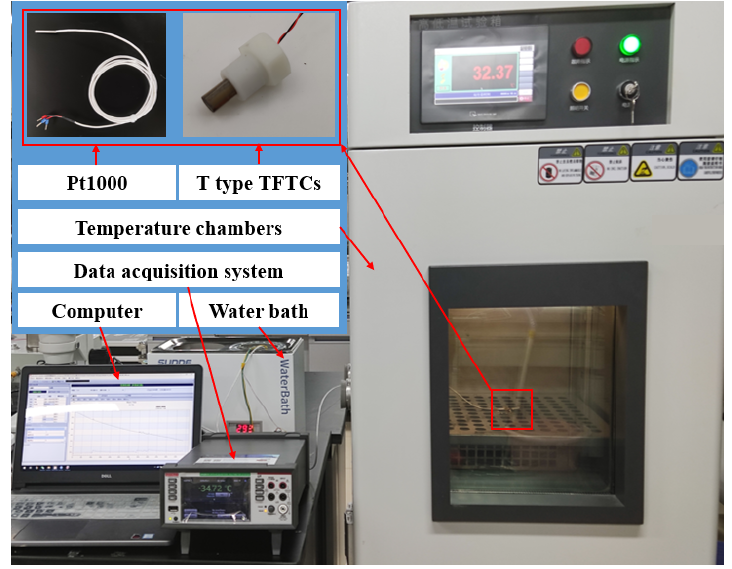
Figure 4. The sample and the schematic of the calibration system for the three-dimensional probe array temperature sensor.